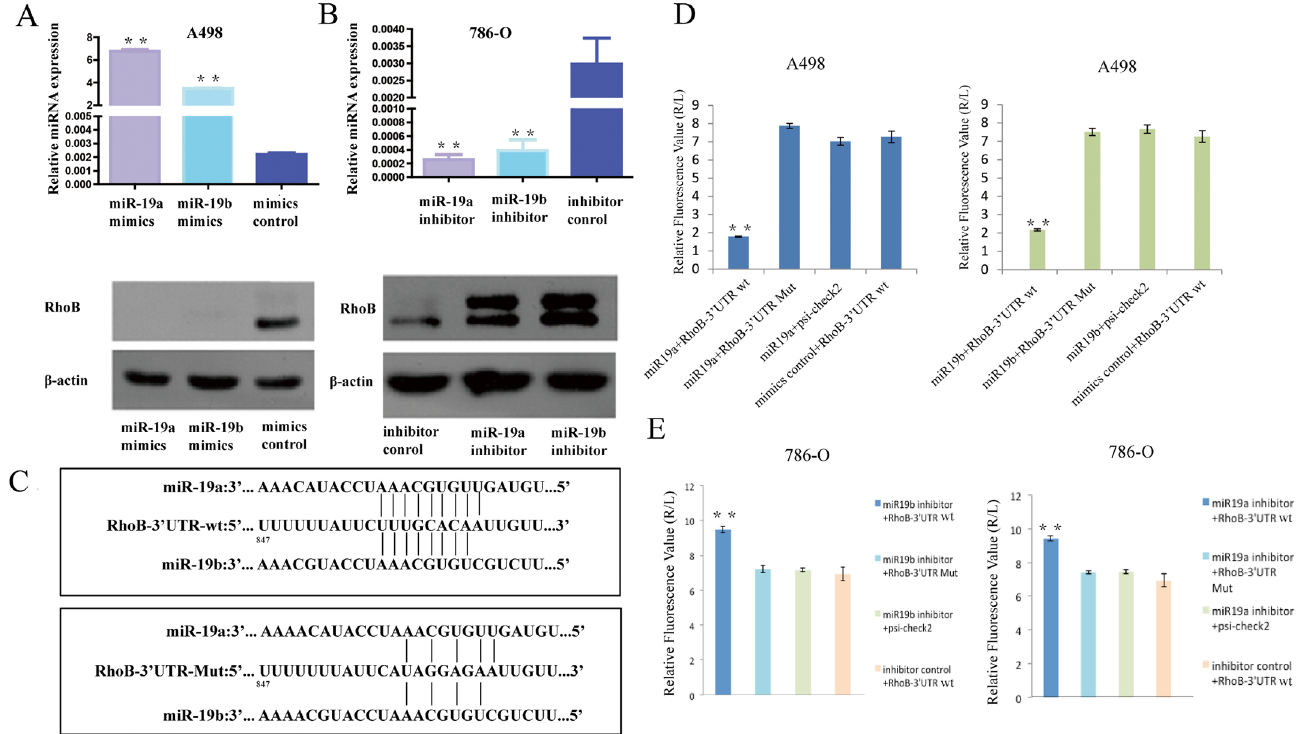
Fig 2. miR-19a and miR-19b regulate RhoB expression. (A and B) QRT-PCR analysis for miR19a/b (top) and Western -blot analysis of RhoB (bottom) expression in A498 and 786-O cells after transfection with miR-19a and miR-19b mimics or inhibitors for 48 h. Control mimics or inhibitors were included as a negative control. β -actin was included for equal protein loading. (C) The predicted binding motif sequence of miR-19a and miR-19b in the 3’-UTR region of RhoB. (D) Reporter assay showing the effect of miR19a/b mimics on the luciferase activity of reporter plasmids containing RhoB-3’UTR-wt, RhoB-3’UTR-mut or empty plasmid psi-check2 in A498 cells transfected with miR19a/b mimics. Control oligo was included as a negative control. (E) Reporter assay showing the effect of miR- 19a and miR-19b inhibitors on luciferase activity of reporter plasmids containing RhoB-3’UTR-wt, RhoB-3’UTR-mut or empty plasmid psi-check2 in 786-O cells. The data represent the average of three independent experiments. (cid:3) Indicates statistical significance (P < 0.05).